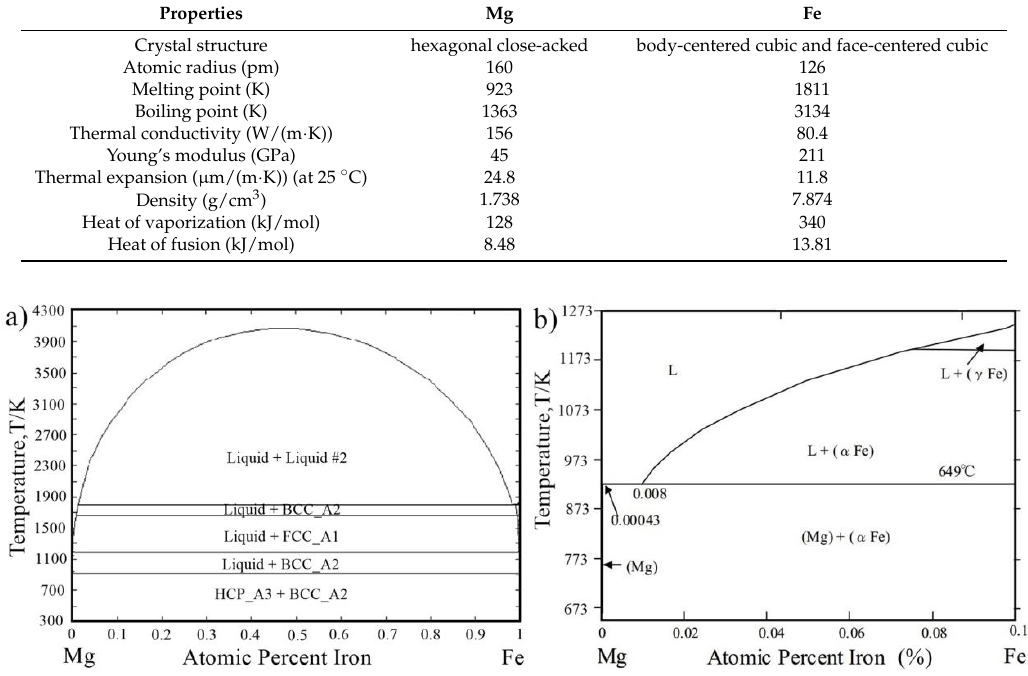
Table 1. The physical and chemical properties of Mg and Fe [8].